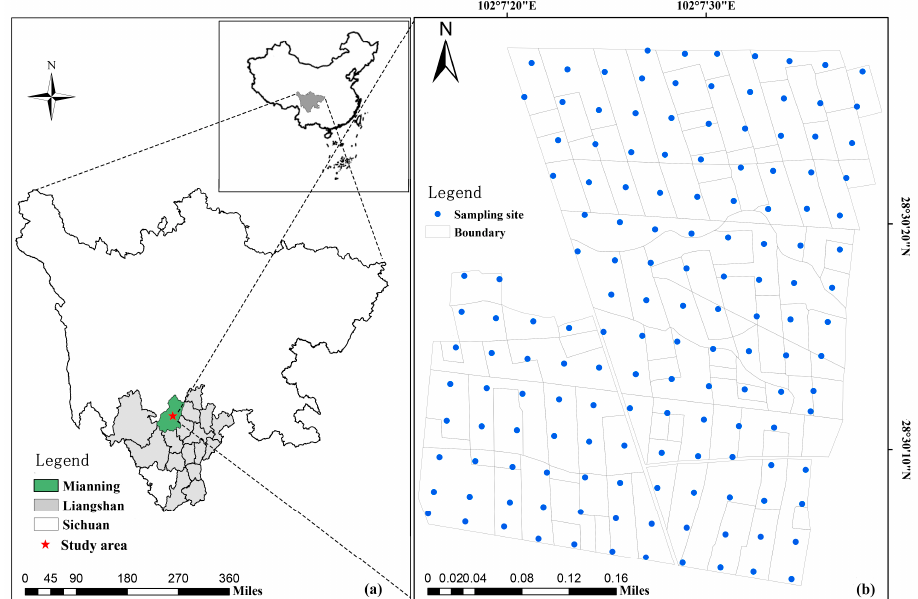
Figure 1. Study area and soil sample spatial distribution. ( a ) Location of the study area and ( b ) the spatial distribution of sampling points and the boundaries of farmland.